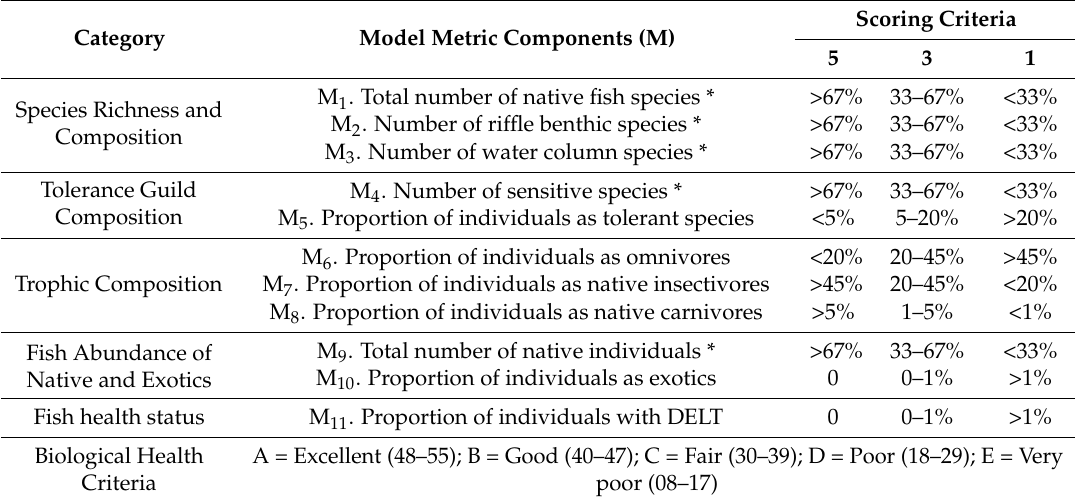
Table 2. Fish assemblages types, metrics and their ascribed scoring criteria in 11 metrics IBI model (mmIBI 11 ).